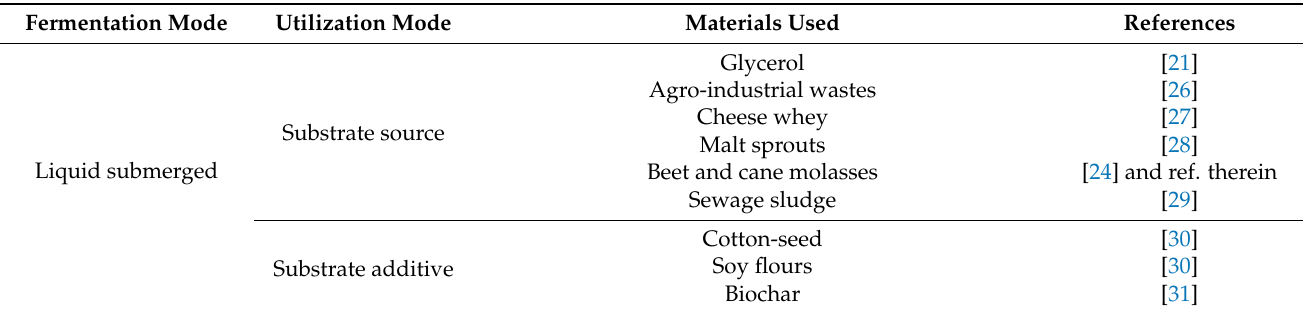
Table 1. Overview of materials used as substrate sources or additives for the development of strategies with different fermentation